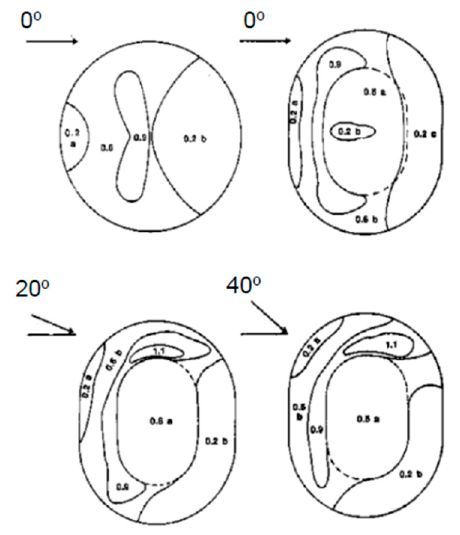
Figure 1. EPA Contours of normalized surface wind speeds